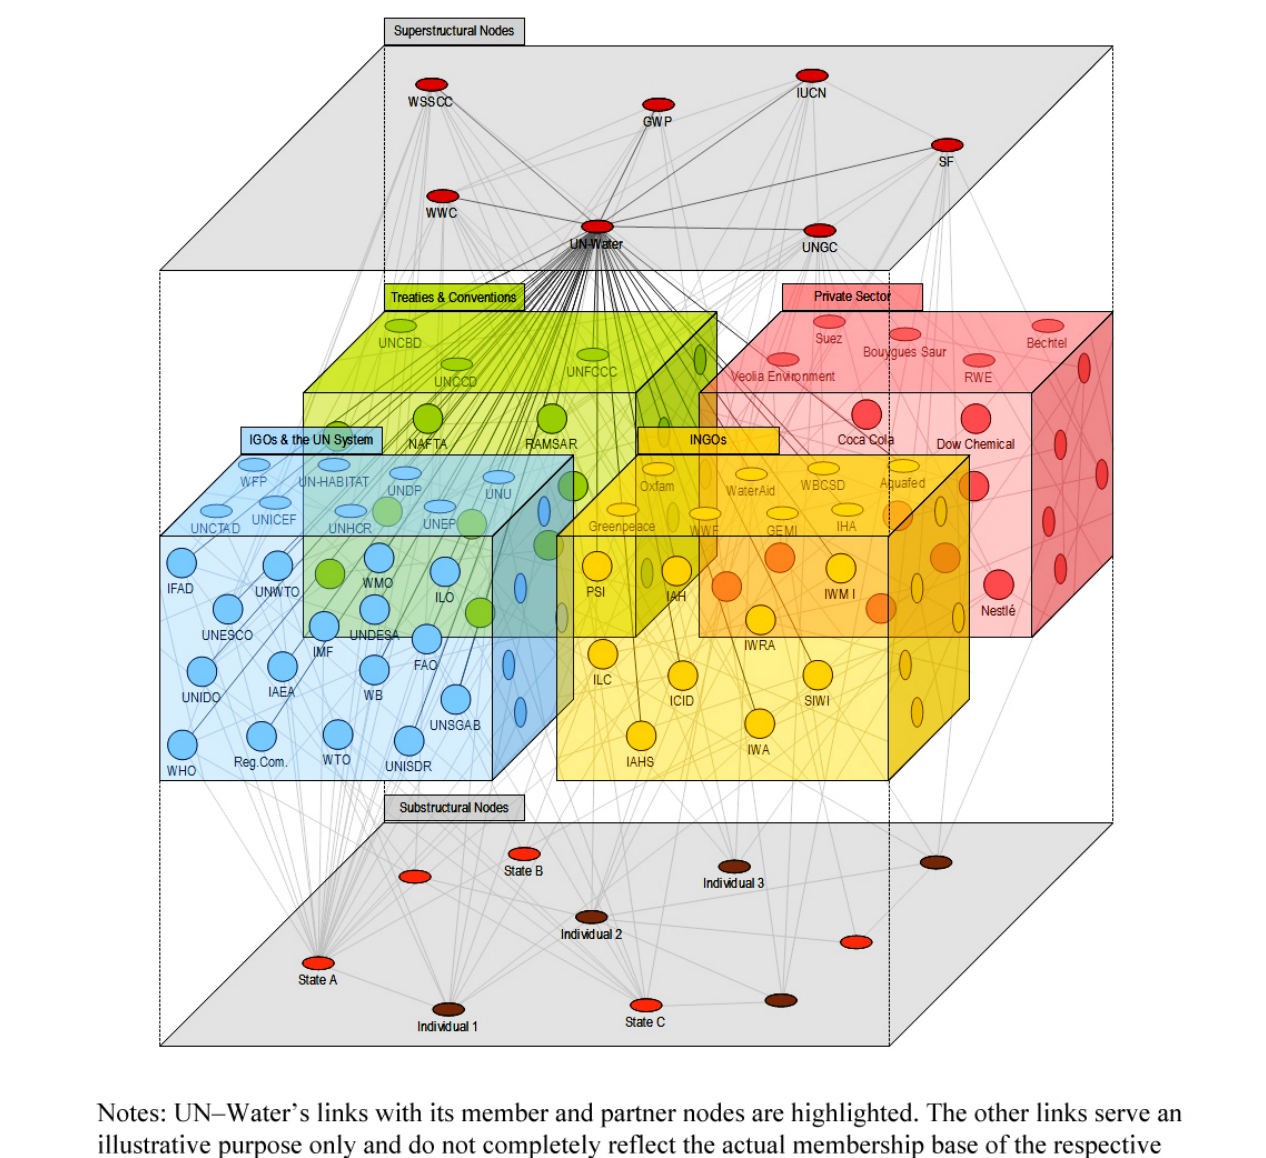
Fig. 2 . Nodal GWG with UN–Water as a superstructural